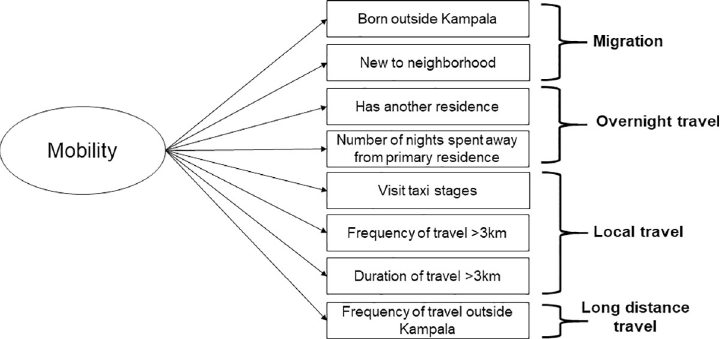
Fig 1. Construct of geographic mobility as a latent variable. Geographic mobility is conceptualized as a latent (unobserved) variable which influences eight observable indicator variables that capture migration, overnight travel, local travel, and long distance travel. Association of mobility with TB